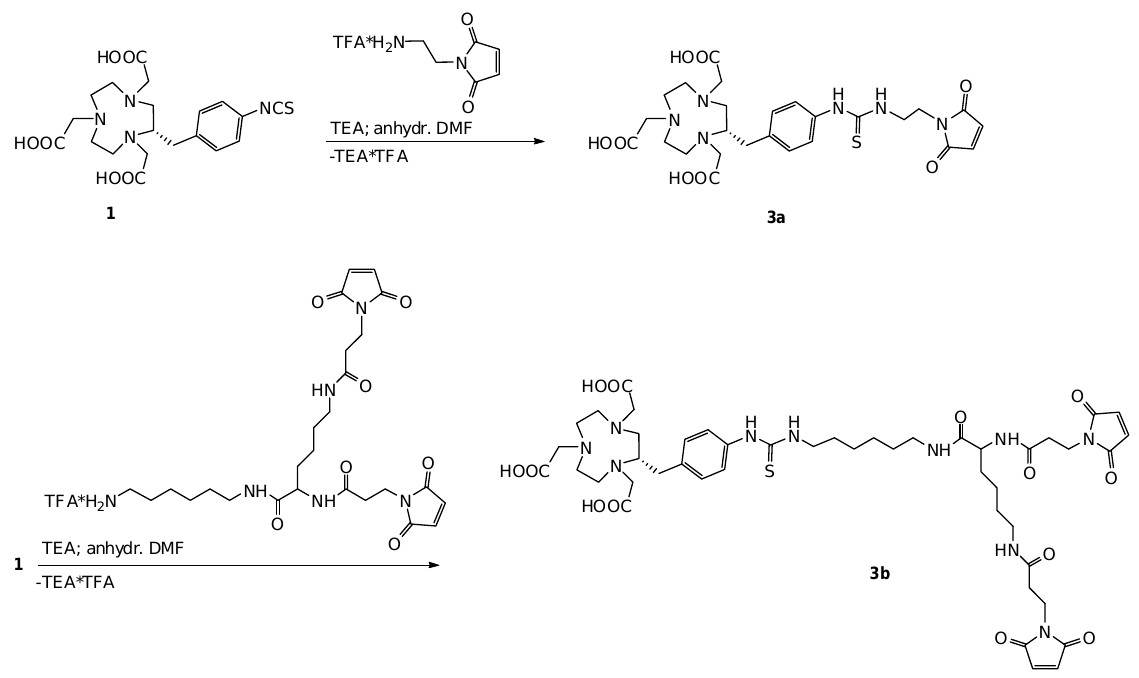
Scheme 2. First reaction pathway for the syntheses of products 3a and 3b